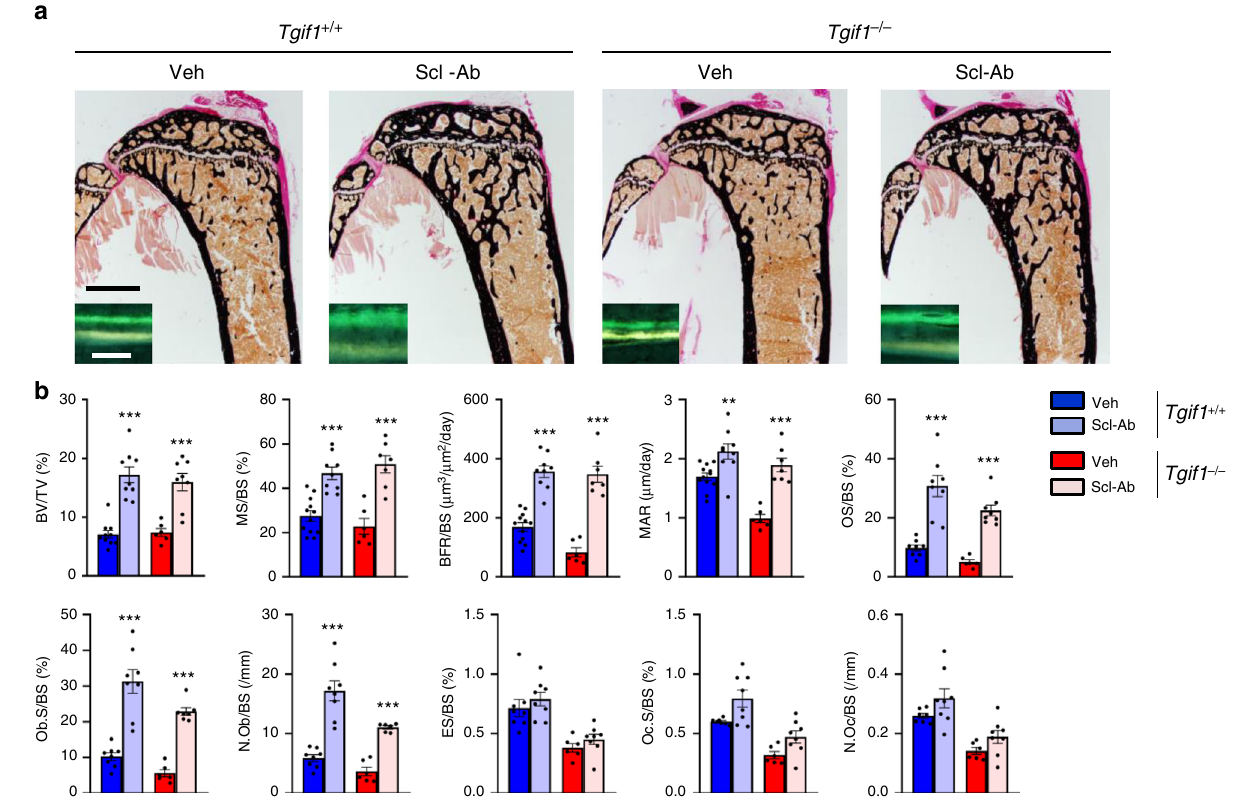
Fig. 4 TG-interacting factor 1 (Tgif1) is dispensable for the bone anabolic function of canonical Wnt signaling. a Representative images of von Kossa- stained histological sections and fl uorescence double labeling to visualize bone formation (insets) of the proximal tibiae of 12-week-old Tgif1 + / + and Tgif1 − / − male mice after treatment with anti-sclerostin antibody (Scl-Ab) or vehicle (Veh). Scale bars indicate 1 mm (black) and 50 μ m (white). b Histomorphometric analysis of the proximal tibiae of 12-week-old male Tgif1 + / + and Tgif1 − / − mice after treatment with Scl-Ab or Veh ( Tgif1 + / + + Veh: N = 12, Tgif1 + / + + Scl-Ab: N = 9, Tgif1 − / − + Veh: N = 6, Tgif1 − / − + Scl-Ab: N = 8). For abbreviations see the legend to Fig. 1. ** p < 0.01, *** p < 0.001 vs. Veh-treated group of the same genotype. Error bars represent the s.e.m. Statistical analysis was performed using analysis of variance (ANOVA)